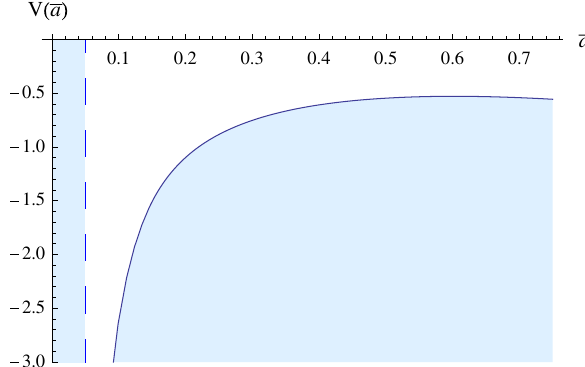
Fig. 10 The evolution of V ( ¯ a ) in the Einstein frame in the case when the evolution of the universe starts from the freeze singularity. For illus- tration it is assumed that f ( ˆ R ) = ˆ R + γ ˆ R 2 + δ ˆ R 3 . This figure corre- spondswithFig.12.The bluedashedlinepresentsthefreezesingularity. The potential V ( a ) is expressed in units of 10 4 km 2 s 2 Mpc